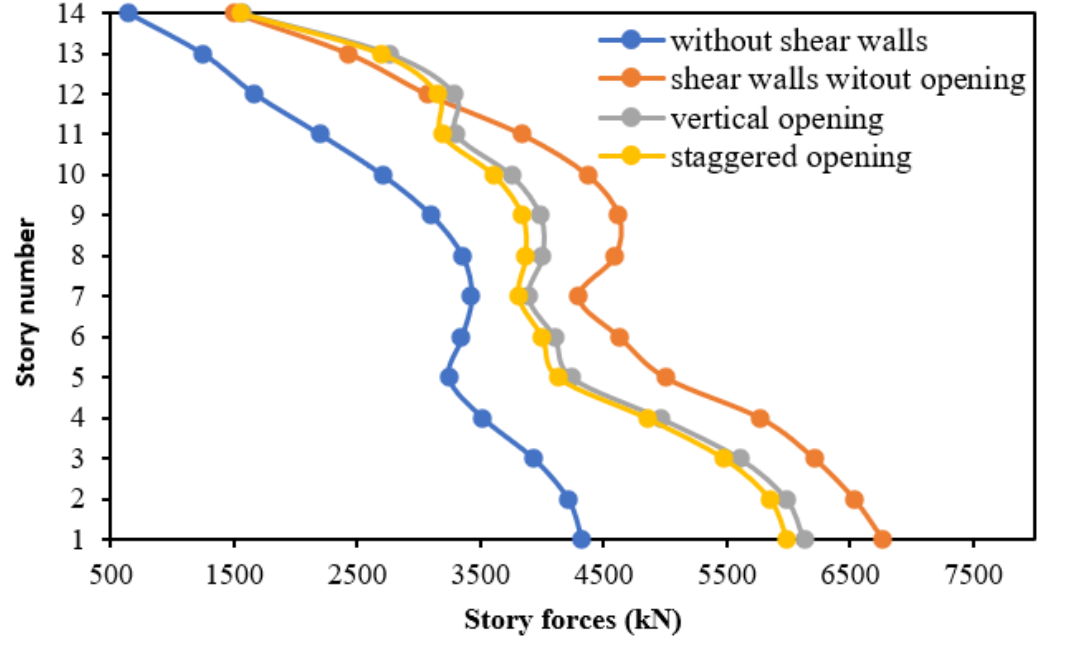
Figure 22. Story forces of the models, time history analysis, Y-direction.